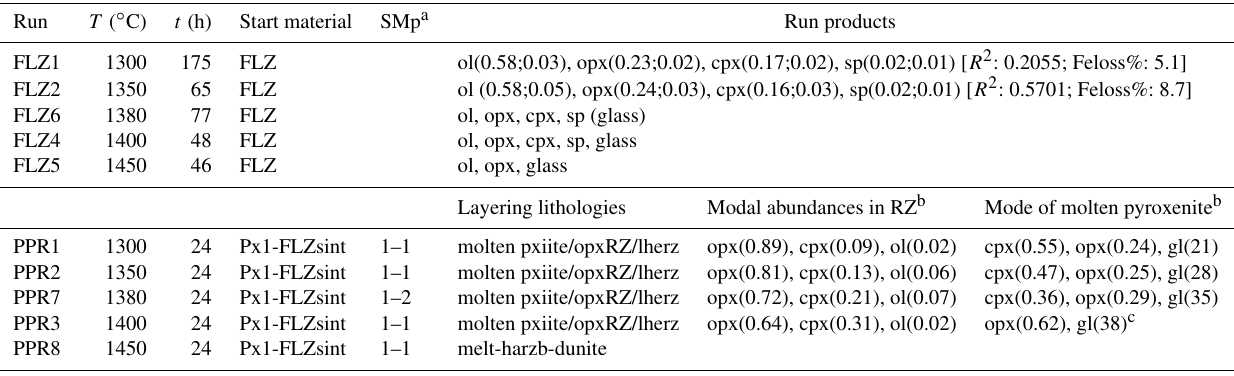
t (h) is run duration in hours. a Starting material proportions. b Modal proportions in the reaction zone (RZ) and partially molten pyroxenite layer estimated by image analysis. c It includes the amount of quenched clinopyroxene. Modal abundances in FLZ runs were computed by weighted least squares mass balance calculations; in parentheses modal fraction and error calculated by Monte Carlo simulation are shown. R 2 is the sum of the squares of residuals: ol, olivine; opx, orthopyroxene; cpx, clinopyroxene; sp, spinels; gl, glass.